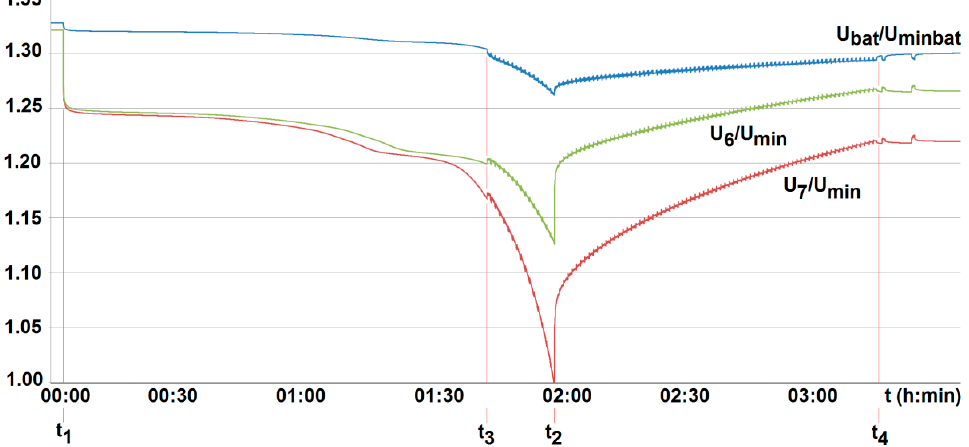
Figure 17. The voltage U 6 /U min and U 7 /U min variation with time for two series-loaded cells (cells no. 6 and no. 7—see Figure 14) of the unburdened battery with the BMS using the battery-to-cell method (room temperature T 0 = 20 °C, free cooling, t 1 , t 2 —moment of switching on and off the load current of 2.5 A, U min —minimum cell voltage equal to 2.5 A, U minbat —minimum battery voltage 20 V, U bat —battery voltage (maximum 29.2 V), t 3 , t 4 —switching on and off the active balancing.